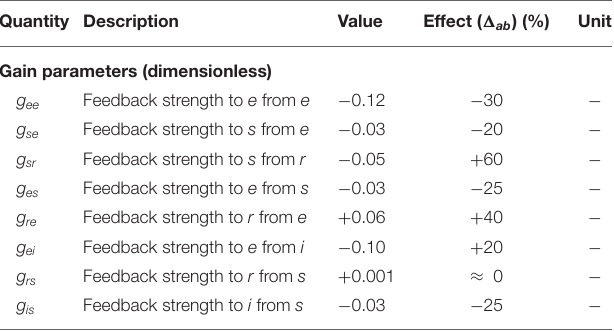
TABLE 2 | Numerically estimated values of modulation terms for normal adults in the alert, eyes-open state, with their effect on resulting gains based on Equation (39).